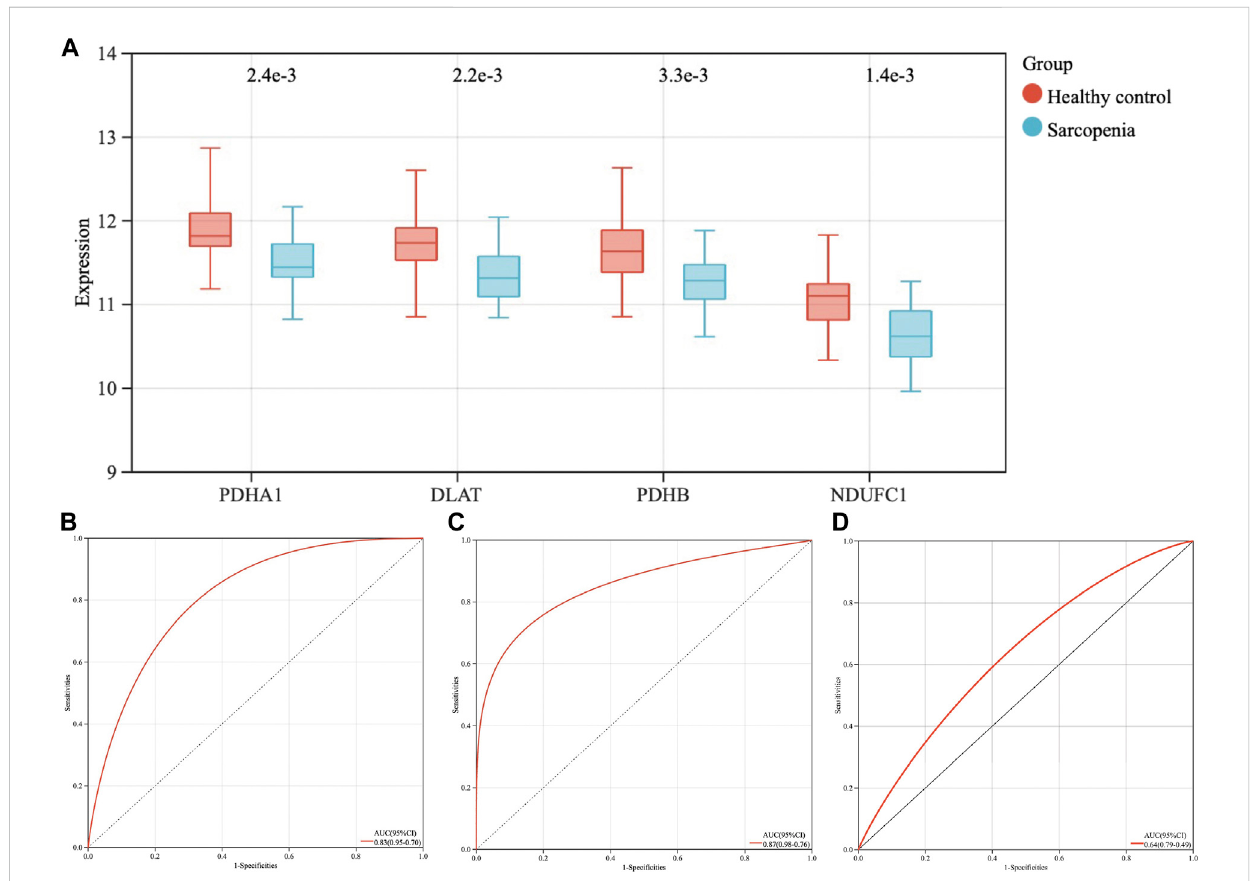
FIGURE 5 Theexpressionlevelsoffourhubgenes,theestablishmentandvalidationofthediagnosticmodelforsarcopenia. (A) TheexpressionlevelsofPDHA1, DLAT, PDHB, and NDUFC1 in sarcopenia group were downregulated in GSE111016 dataset. (B) Receiver operating characteristic (ROC) curve and area under the curve (AUC) statistics of predictive model of sarcopenia in GSE111016 dataset. ROC curves and AUC statistics to assess diagnostic ef fi ciency of hub genes on the identi fi cation of sarcopenia in GSE111006 (C) and GSE167186 dataset (D)